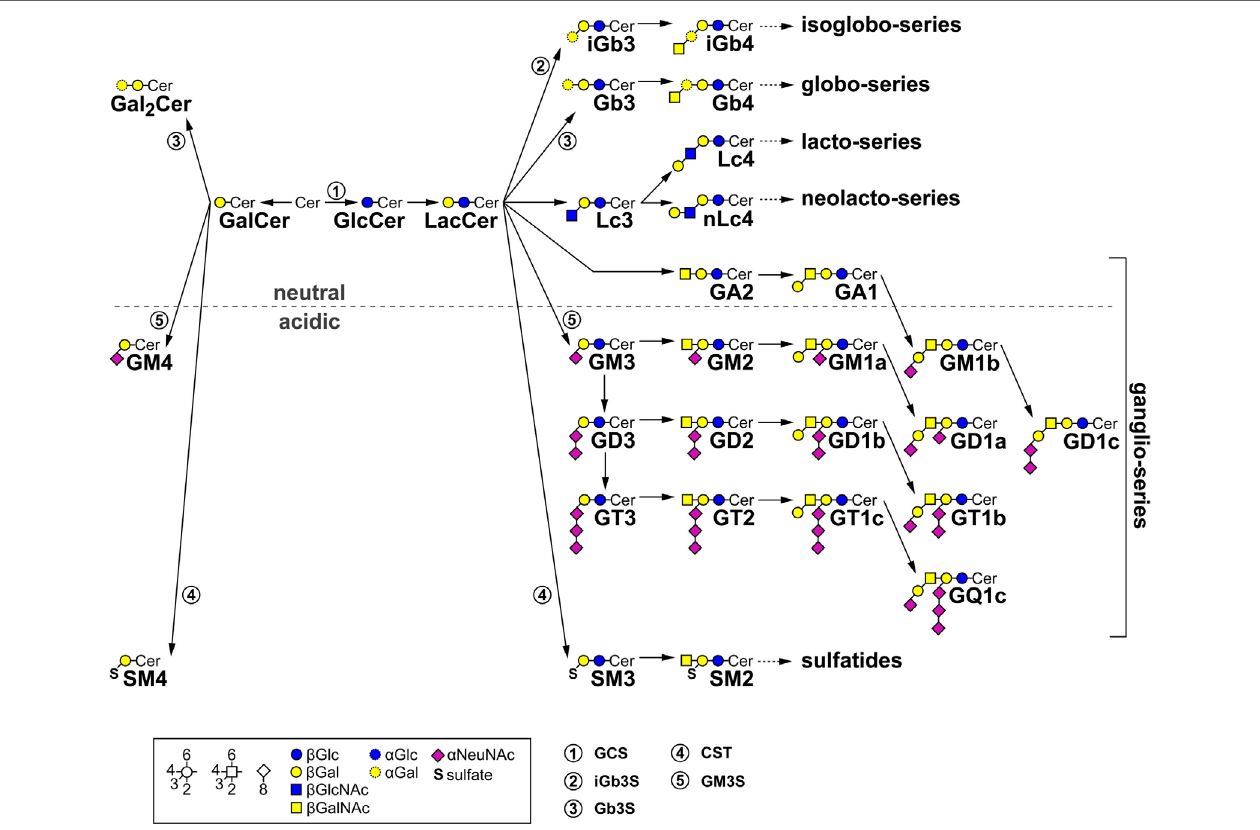
FigUre 1 | Metabolic glycosphingolipid (GSL) pathways. The diagram shows the most important mammalian metabolic GSL pathways starting from ceramide (Cer). Depending on the first sugar moiety, either galactosylceramide (GalCer) or glucosylceramide (GlcCer) are formed. GlcCer is processed to lactosylceramide (LacCer). By subsequent action of further enzymes on either GalCer or LacCer, individual series of GSL emerge. The presence of an acidic moiety [ N -acetylneuraminic acid ( α NeuNAc) in gangliosides or sulfate (S) in sulfatides, respectively] results in an acidic character of these GSL. Relevant synthesis enzymes are indicated as encircled numbers: 1, GlcCer synthase (GCS); 2, isoglobotriaosylceramide (iGb3) synthase (iGb3S); 3, globotriaosylceramide (Gb3) synthase (Gb3S); 4, cerebroside sulfotransferase (CST); and 5, GM3 synthase